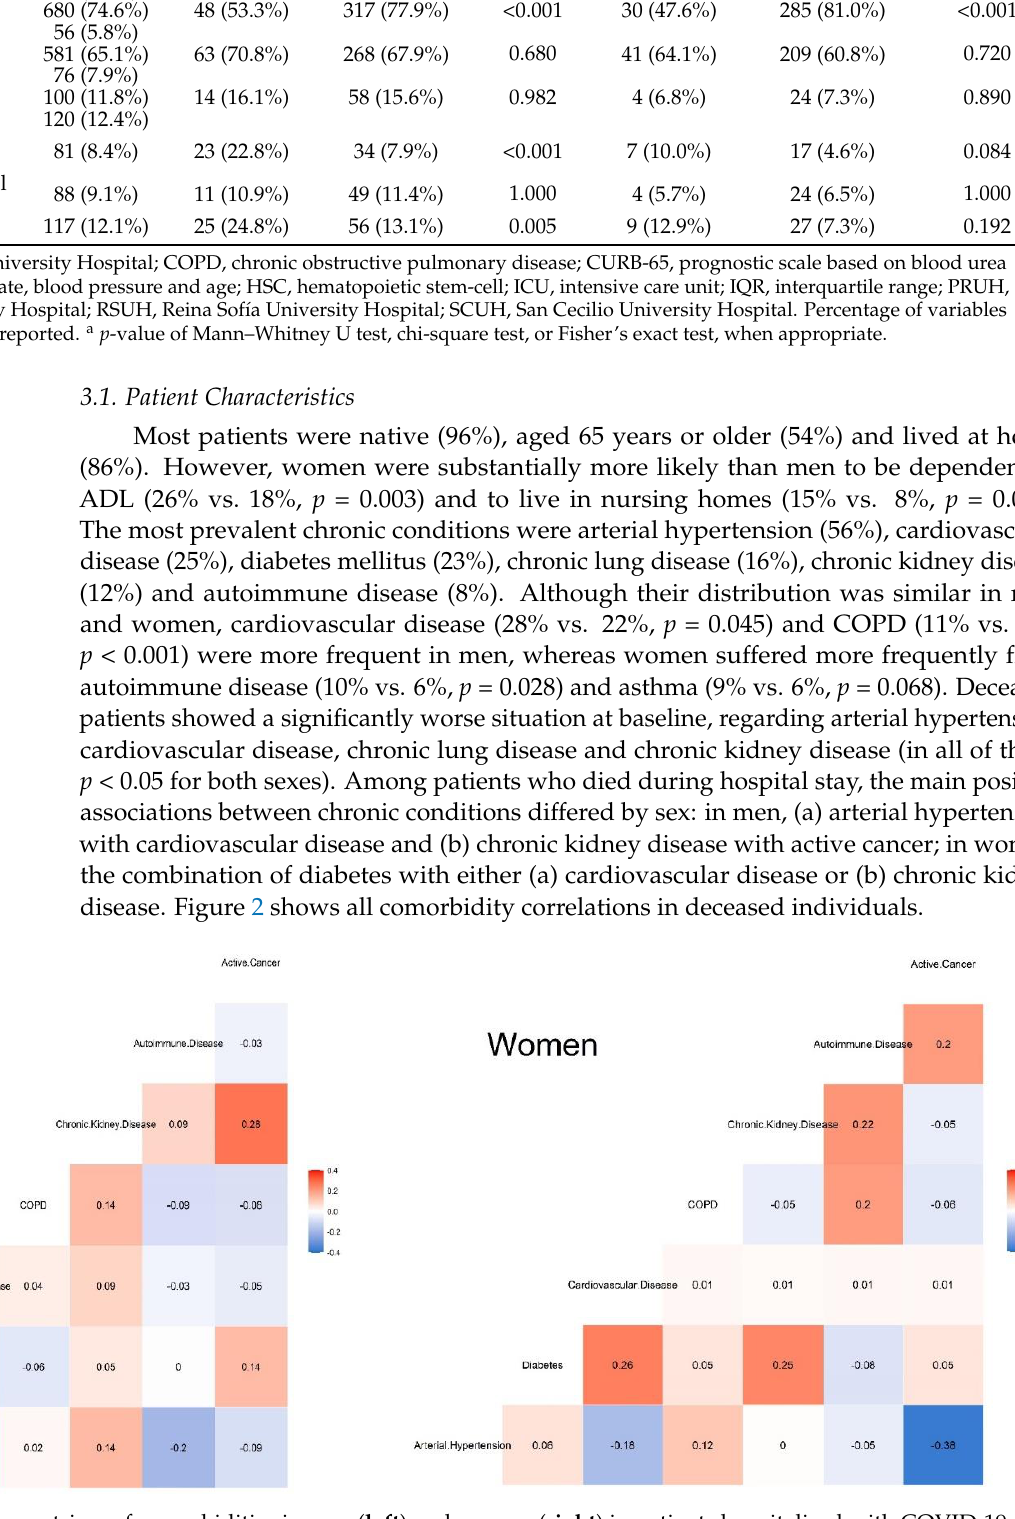
Figure 2. Correlation matrices of comorbidities in men ( left ) and women ( right ) in patients hospitalised with COVID-19 who died during hospital stay.